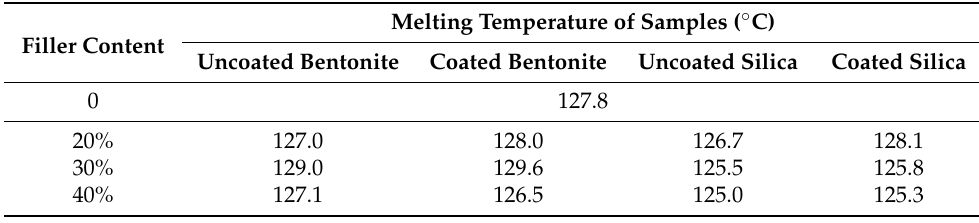
Table 1. The melting temperature of the masterbatches.